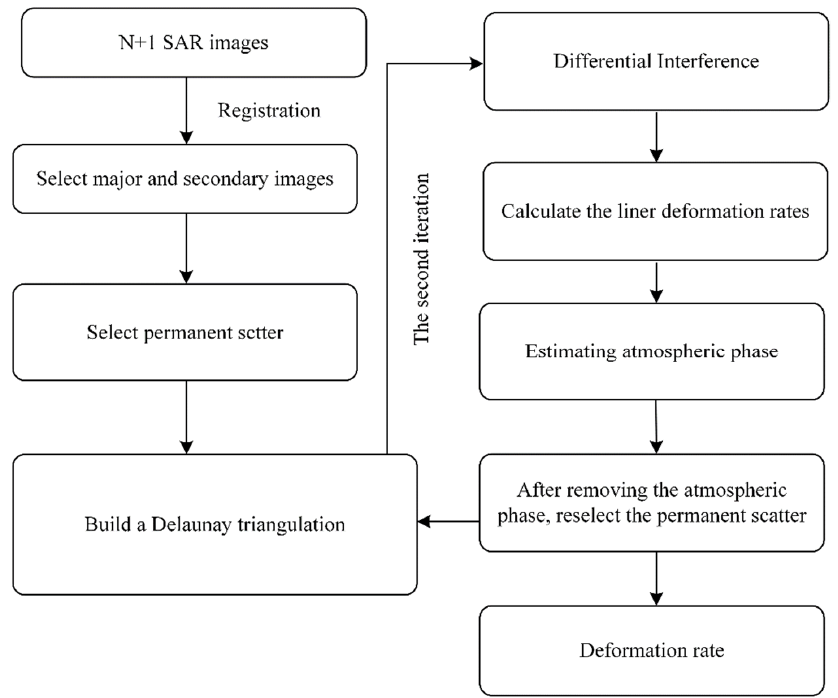
Figure 6. The framework of PS-InSAR analysis. The final deformation rate results of N+1 SAR data are obtained by the flow in the figure.